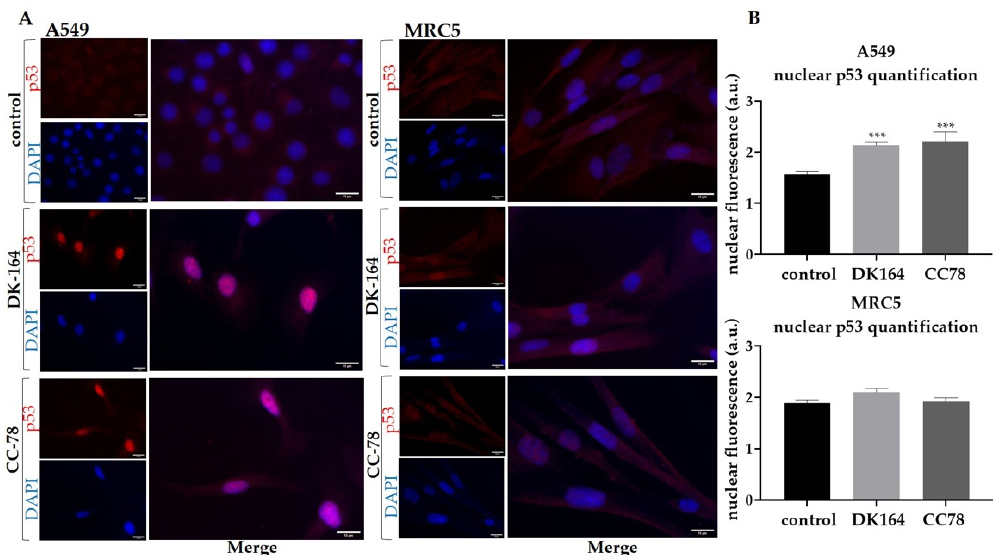
Figure 6. Activation and nuclear translocation of the p53 protein in A549 and MRC5 cells. ( A ) Representative immunofluorescence images of A549 and MRC5 control cells and cells treated with the calculated IC50 concentrations of DK-164 or CC-78 for 48 h and labelled with anti-p53 antibody (red). DNA was co-stained with DAPI (blue). ( B ) Quantitative determination of the intensity of the p53 protein was performed by CellProfiler cell image analysis software and GraphPad Prism 8.0. A p -value < 0.05 was considered statistically significant, *** p < 0.005. Quantification is based on three independent experiments with >50 cells scored for each condition. Error bars represent the standard deviation (SD). a.u.: arbitrary unit. The scale bar corresponds to 15 m.